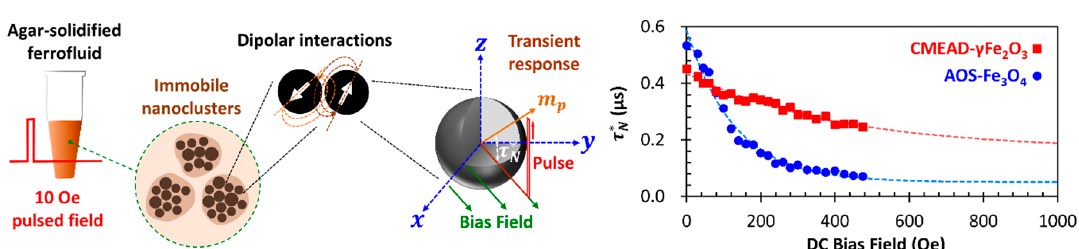
Figure 5. Field-dependent effective Néel time constant (cid:2028) (cid:3015)∗ (cid:4666)(cid:1834)(cid:4667) of the immobilized CMEAD- γ Fe 2 O 3 (solid squares) and AOS-Fe 3 O 4 (solid circles) nanoparticles representing the damping behavior of the particle moment (cid:1865) (cid:3043) .